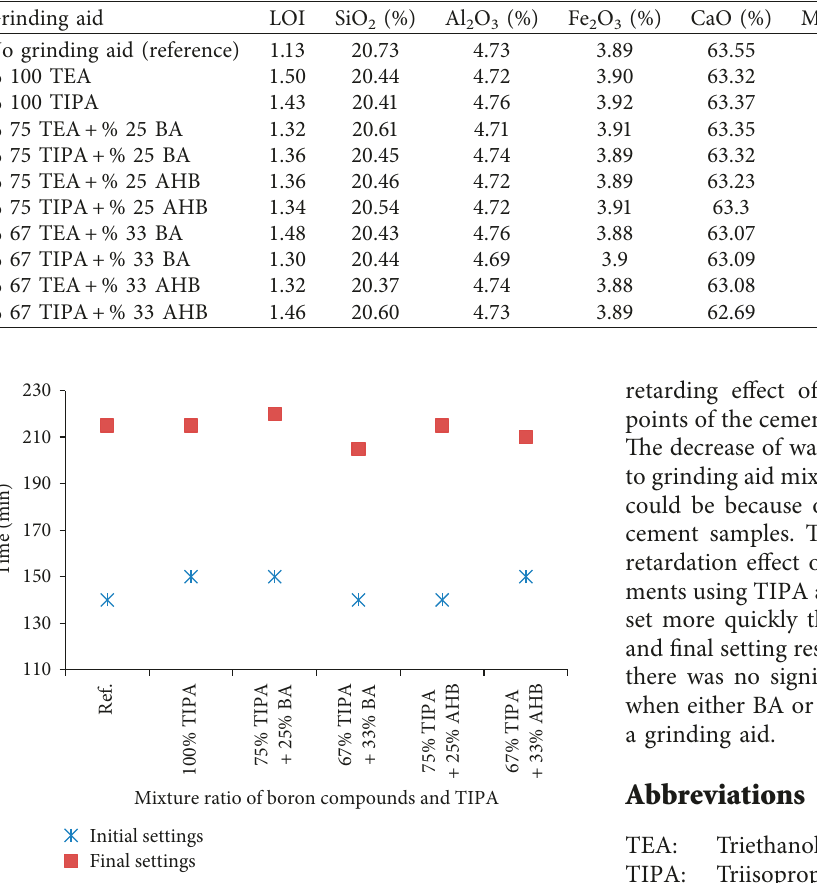
Figure 2: The initial and final setting points of the reference cement and cement mixtures milled with TIPA and different ratios of BA and AHB mixtures as grinding